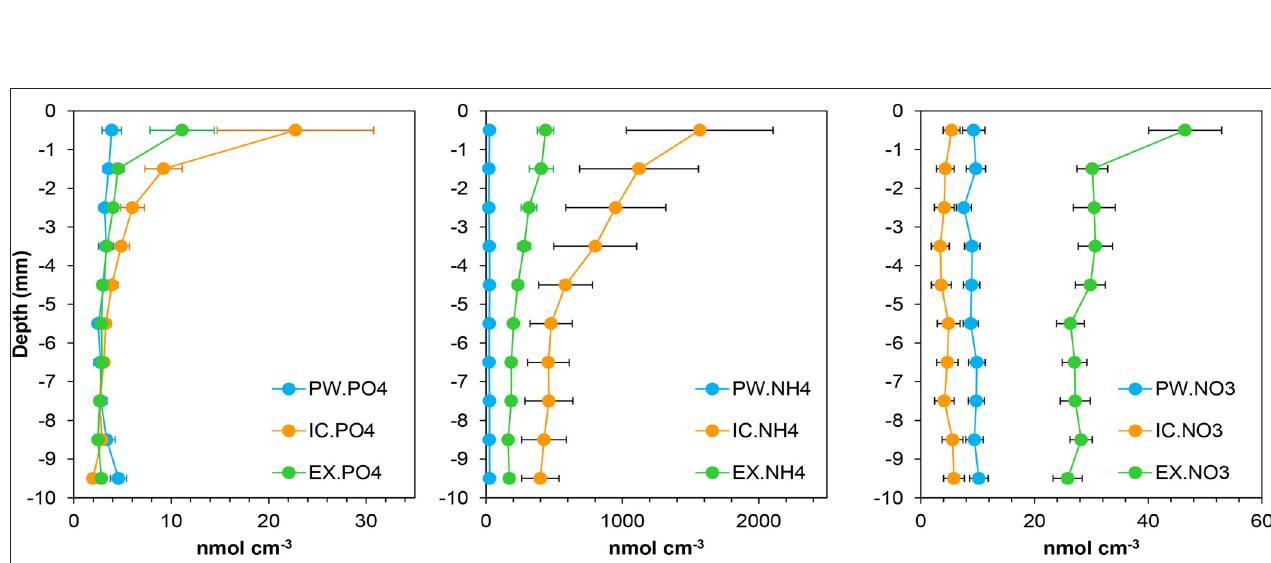
FIGURE 2 | Mean profiles of the nutrient pools content in the porewater (PW), intracellular (IC), and KCl exchangeable (EX) fractions at the sampling station on Trocadero Island, Bay of Cádiz. Data are mean of 17 months ± SE (from January 2008 to June 2009).